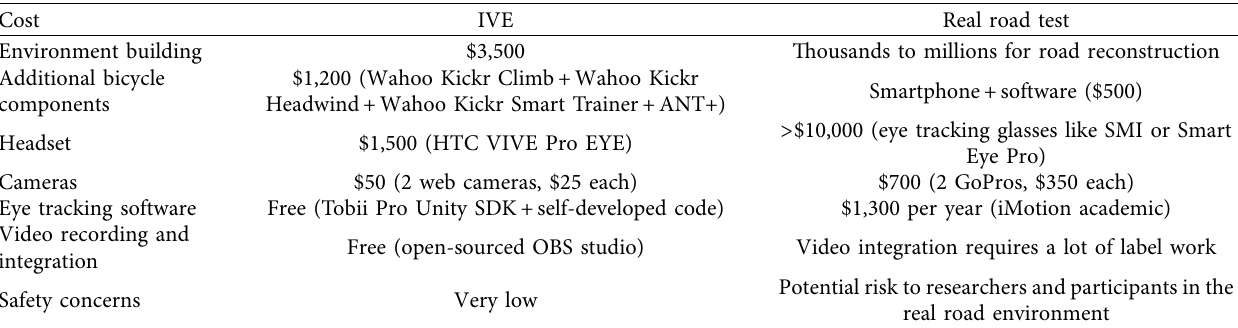
Figure 3: Appearance of the simulators: (a) bicycle simulator; (b) pedestrian simulator. Table 4: Cost comparison between the IVE and naturalistic